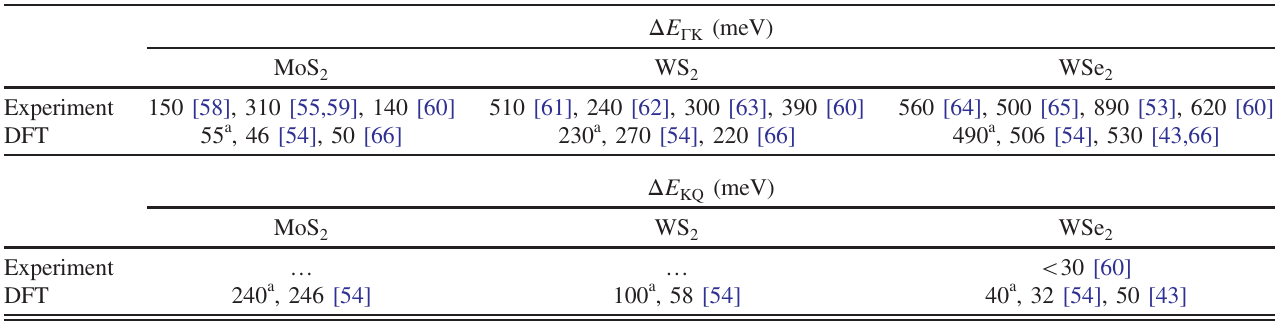
TABLE I. Energy separation between the top of the valence band at K and Γ ( Δ E Γ at K and Q ( Δ E ) in the monolayer TMDs investigated in this work. Experimental results are taken from angle-resolved photoemission KQ spectroscopy (ARPES) measurements in the literature. DFT data refer to calculations performed with the same exchange-correlation functional (PBE [57]) on the DFT-relaxed crystal